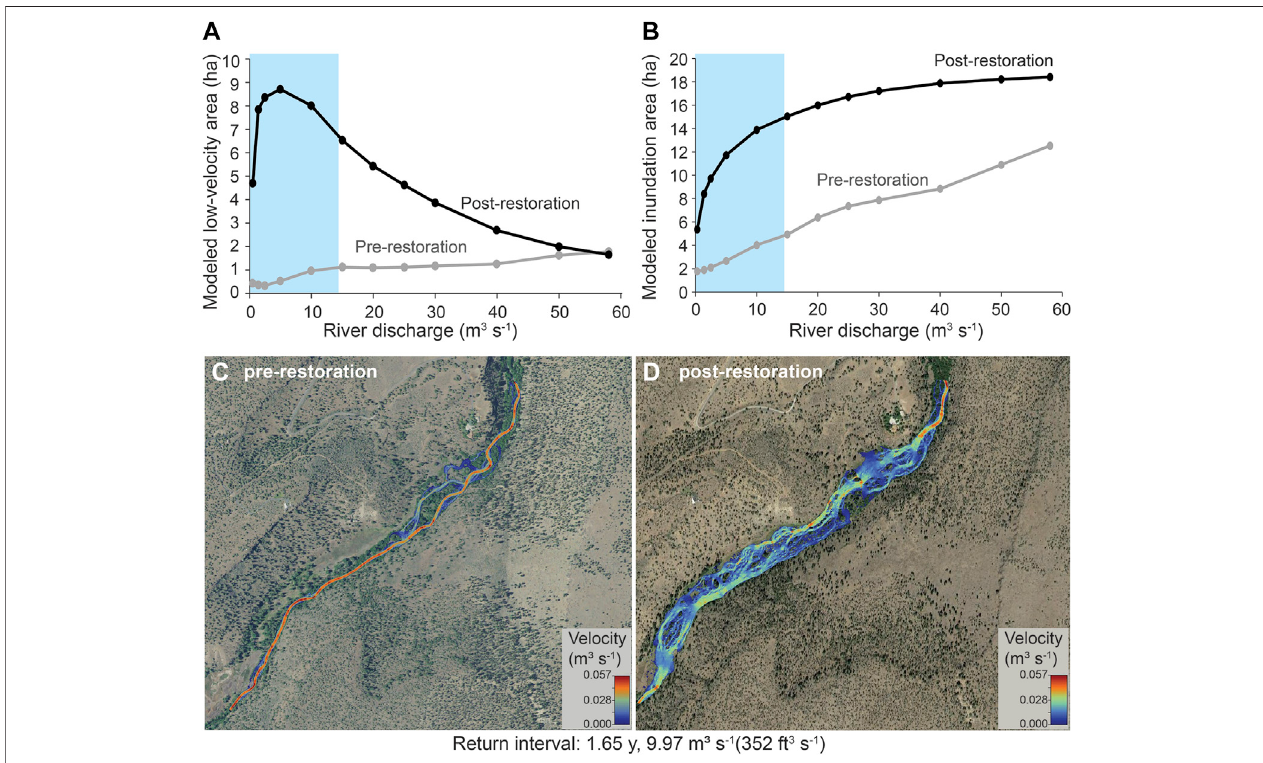
FIGURE13| VelocitymodelingattheWhychusCreekatWhychusCanyonrestorationsiteshow: (A) suitablejuvenilesalmonidrearinghabitatforthepre-andpost- restoration conditions (blueshaded area delineates fl ow conditions for rearing); (B) modeled inundation area across river discharge levels for pre and post-restoration valley con fi gurations; (C) mapped pre-restoration velocity for one commonly occurring winter fl ow of 10 cms, and; (D) mapped post-restoration velocity for one commonly occurring winter fl ow of 10 cms.